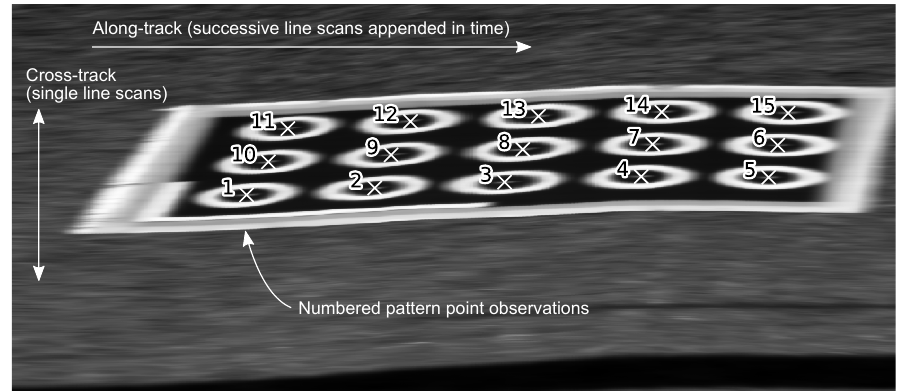
Figure 7. Close-up view of the observation indicated in Figure 6, showing manually labelled calibration point locations (white crosses) with ID numbers. Each 648 pixel line scan is vertical and concatenated horizontally. A similar image was generated for each observation of the calibration pattern prior to manually labelling each point. Care was taken to ensure the numbering scheme remained consistent for all observations of the